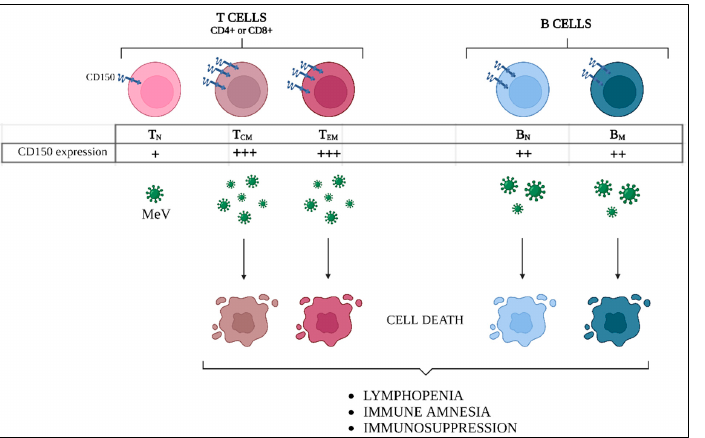
Figure 5. MeV-induced adaptive immune amnesia. Differential CD150 expression levels in lymphocyte populations induce different susceptibility to MeV infection. Central memory (T CM ) and effector memory (T EM ) T cells express higher CD150 levels compared to naïve T lymphocytes (T N ), while intermediate levels are found in both naïve and memory B cells (B N and B M ). As a consequence, massive cell death of T CM , T EM , and B M occurs, thus explaining the prolonged lymphopenia and immune suppression during measles